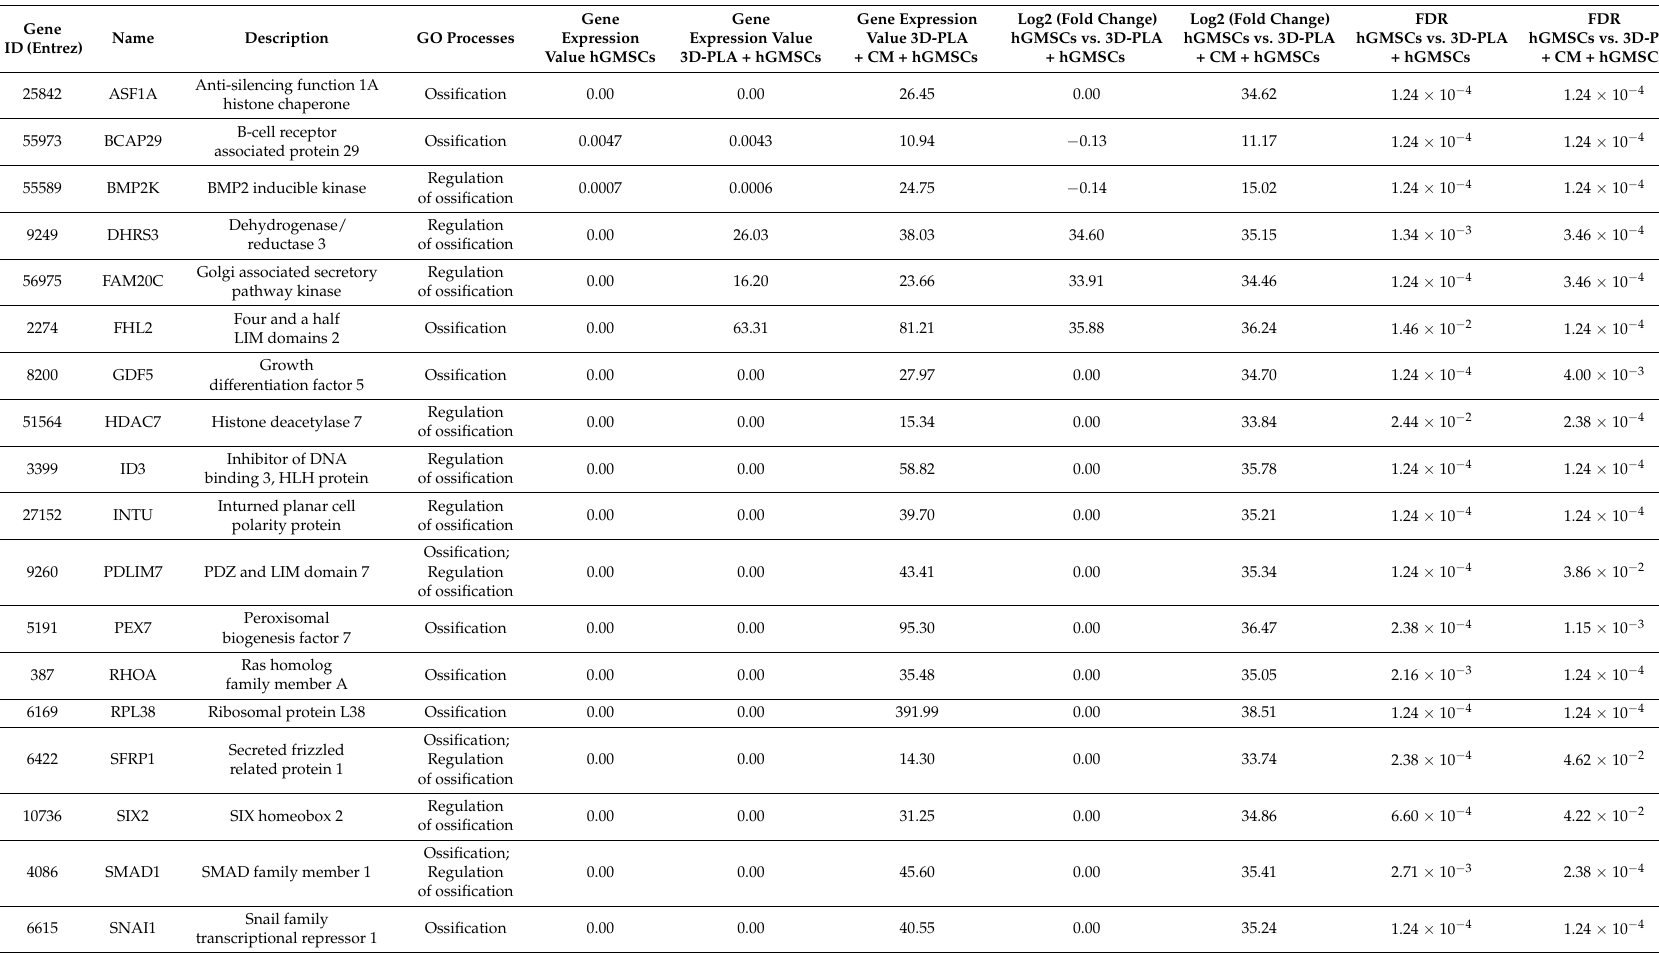
Table 1. Gene expression levels, fold changes, gene ontology (GO) and false discovery rate (FDR) of differentially expressed genes in human gingival mesenchymal stem cells (hGMSCs), poly-(lactide) (3D-PLA) scaffold + hGMSCs and 3D-PLA + conditioned medium (CM) +